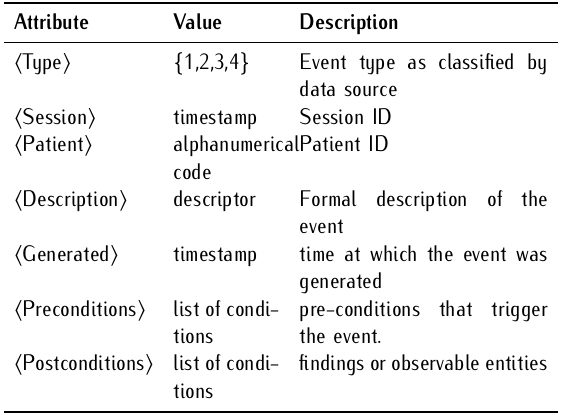
Table 2. The Event